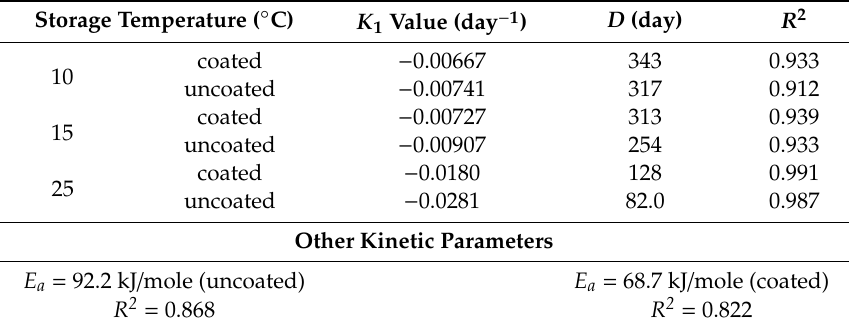
Table 4. Kinetic parameters for ascorbic acid changes of coated and uncoated limes stored at different temperatures.